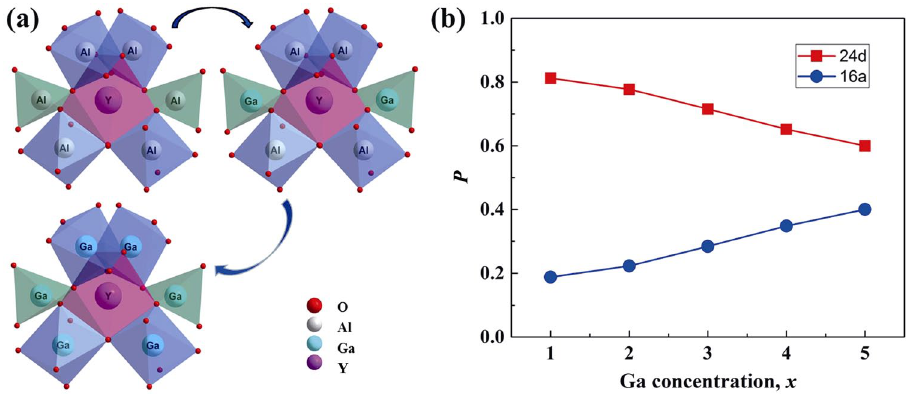
Fig. 4 (a) Illustration of YAGG crystalline structure, (b) probability of Ga ions occupying octahedral (16a) and tetrahedral (24d) sites varying with Ga content.